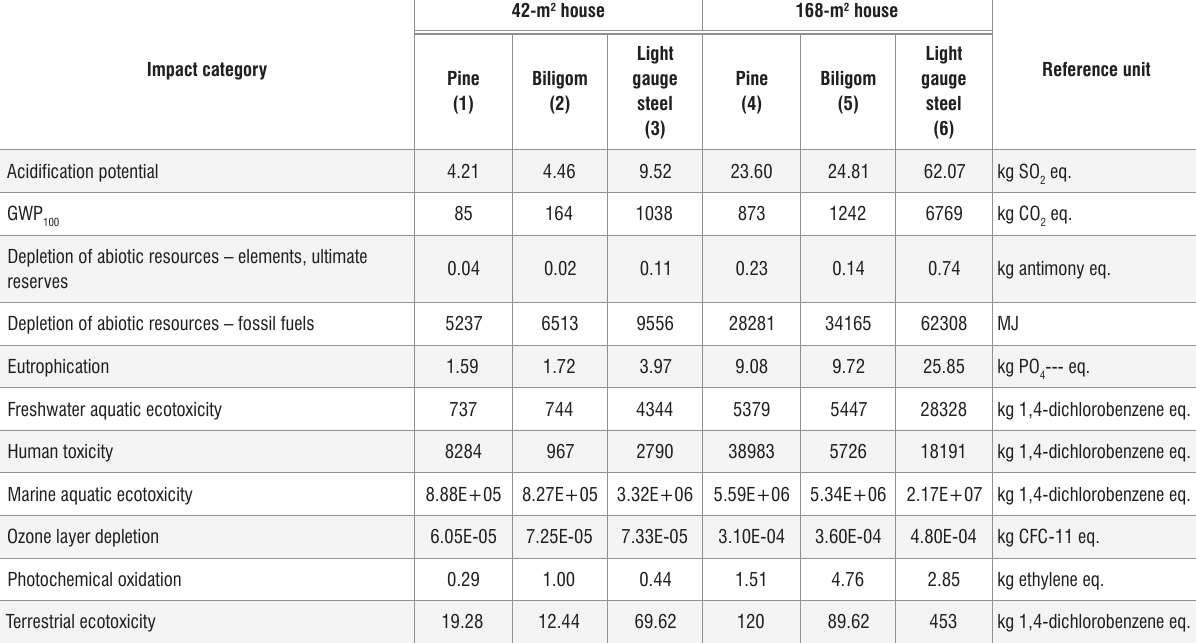
Cradle-to-grave roof truss alternative impact assessment summary for the two roof designs